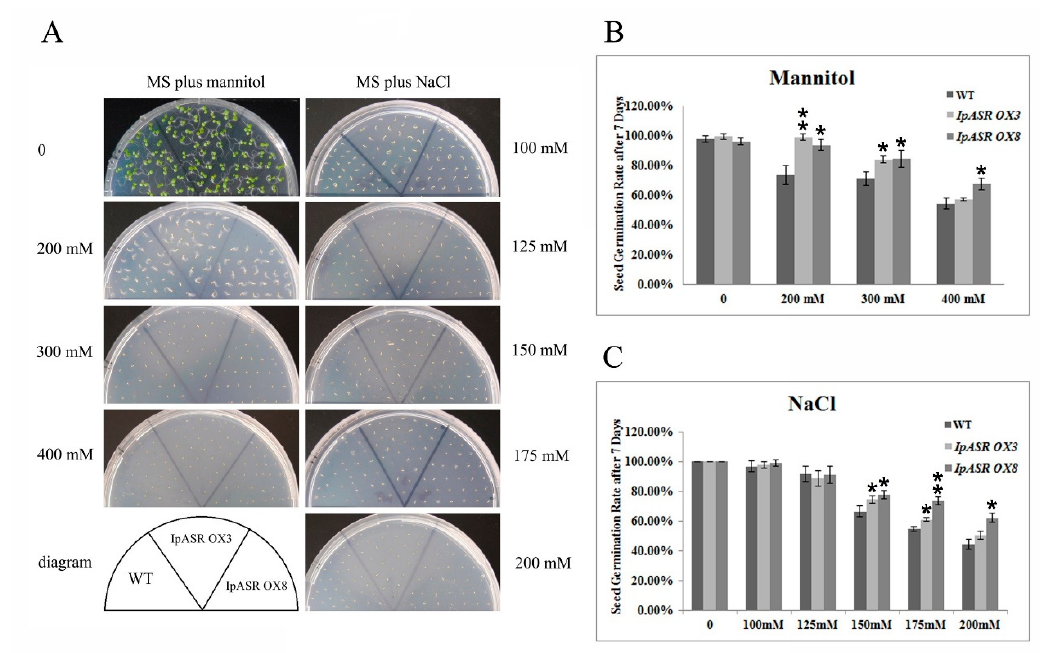
Figure 8. Osmotic and salt stress analyses of transgenic plants with IpASR with regards to seed germination rate. ( A ) Photographs of transgenic lines ( IpASR OX3 and IpASR OX8 ) and WT seeds germinated on MS (Murashige and Skoog) medium or MS medium with mannitol (left, 200, 300 and 400 mM) or NaCl (right, 100, 125, 150, 175 and 200 mM) for 7 days. ( B , C ) Seed germination rates in WT and transgenic lines under mannitol ( B ) and NaCl ( C ) stress after 7 days. Error bars indicate the SD based on over three replicates ( n ≥ 3). Asterisks indicate significant differences from the control (Student’s t -test p values, * p < 0.05 and ** p < 0.01).